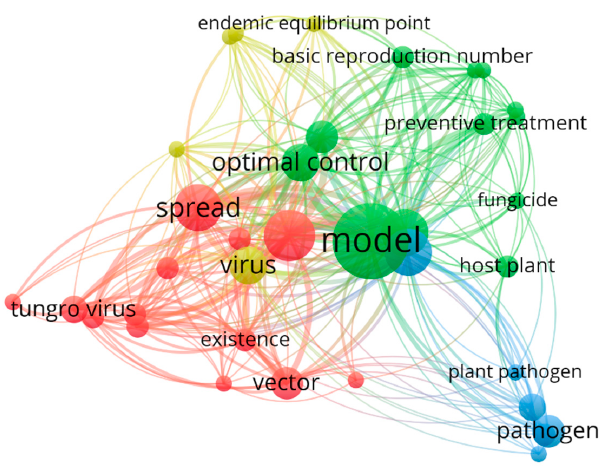
Figure 10. Mapping the topic of the spread of tungro disease in rice plants.